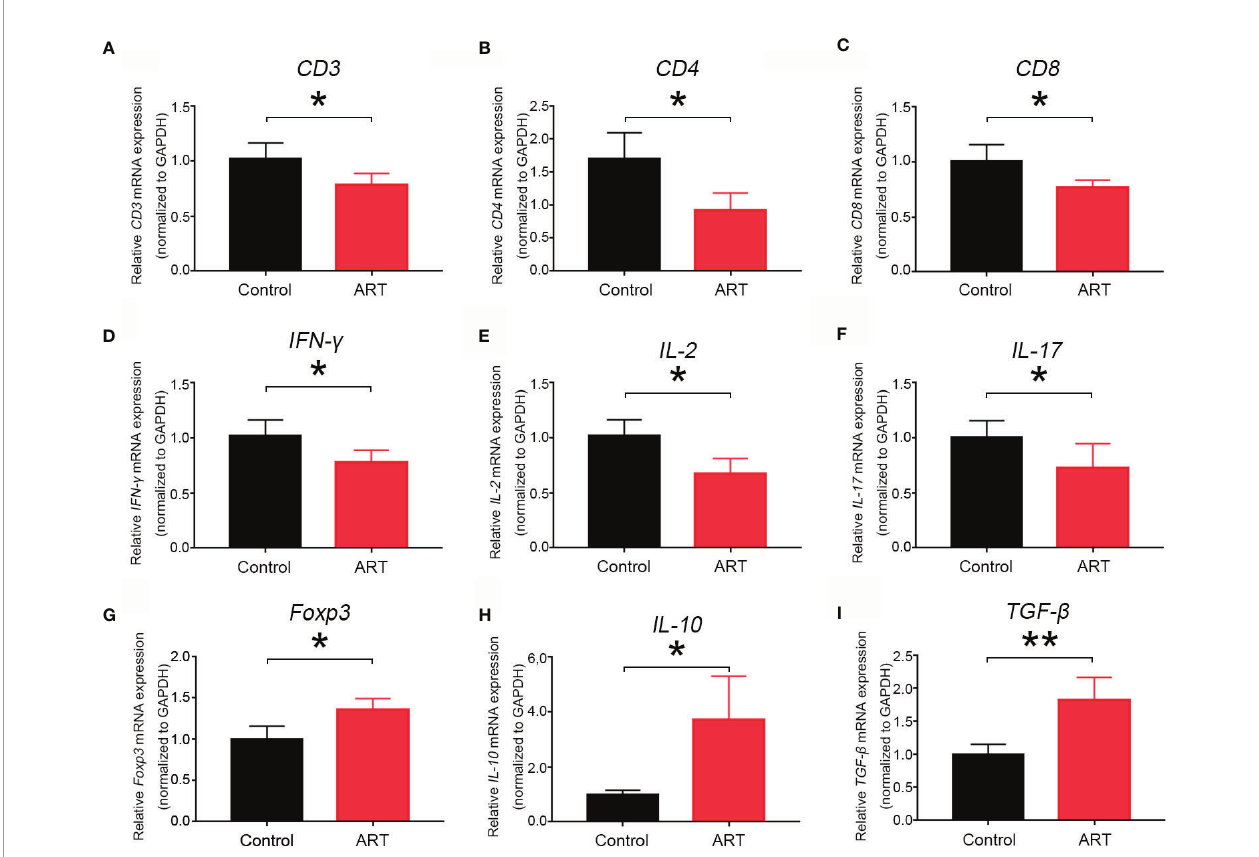
FIGURE 3 | Artemisinin (ART) inhibits mRNA expression levels of T cell-associated markers and pro-in fl ammatory cytokines and promotes mRNA expression of Treg- associated cytokines. The mRNA expression of T cell-associated markers (A – C) , T-cell-associated pro-in fl ammatory cytokines (D – F) , and Treg-associated cytokines (G – I) were determined by qPCR. The mRNA levels were normalized to those of GAPDH . Three independent experiments were performed showing similar results. * P < 0.05; ** P <